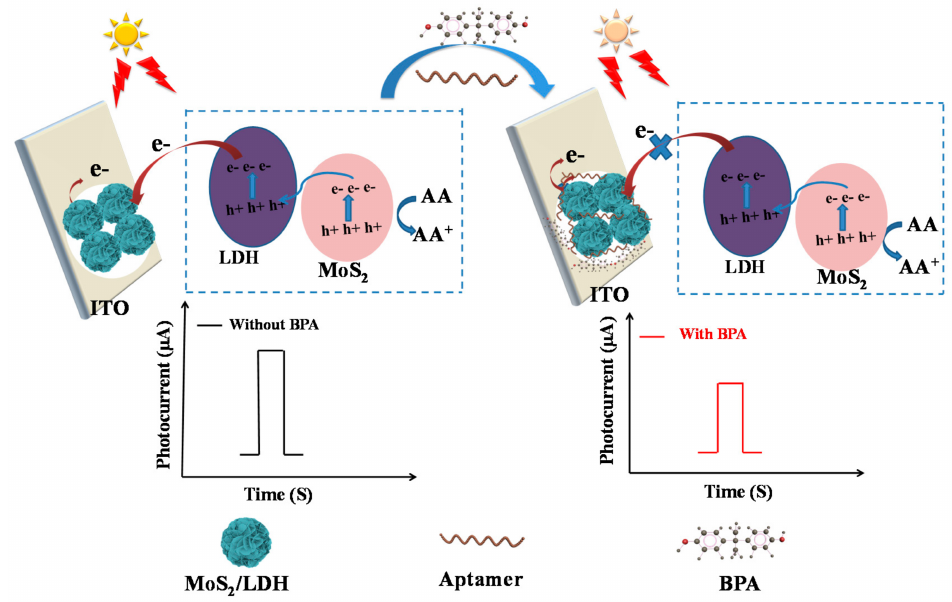
Scheme 1. Mechanism of the PEC property based on aptamer/MoS 2 /LDH-5% for